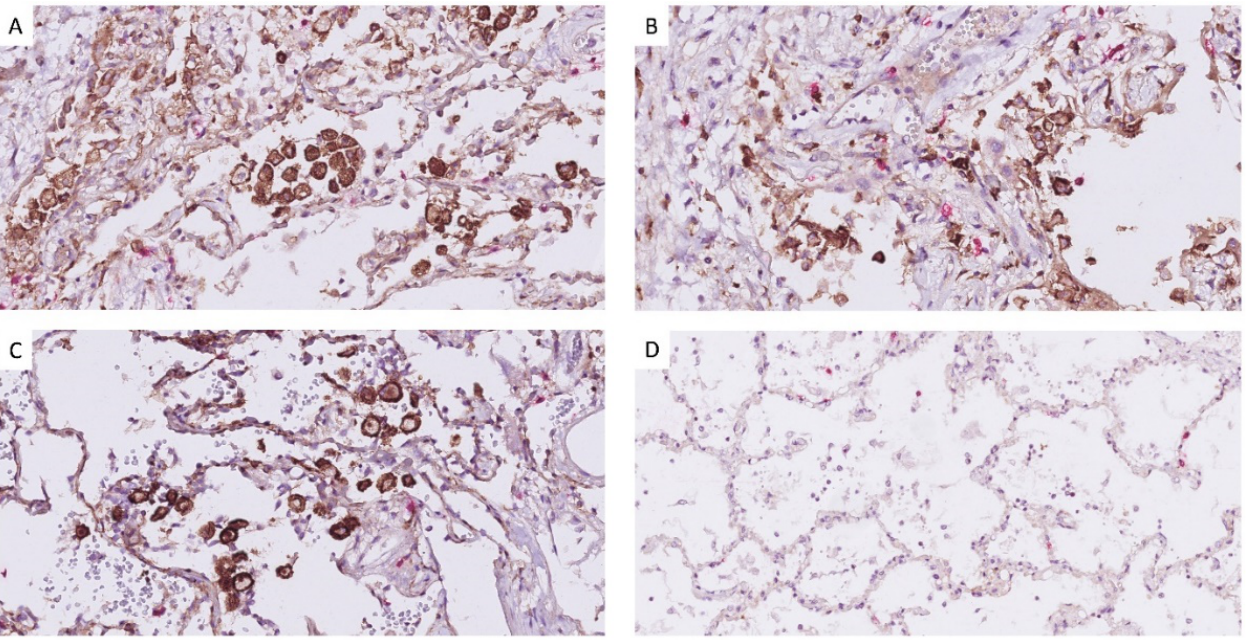
Figure 3. The increased expression of PD-L1 in lung tissue of deceased COVID-19 patients. PD-L1 is expressed on macrophages which are morphologically recognizable (stained in brown) and CD8 + T-cells (stained in red). ( A ) patient C10, ( B ) patient C11, ( C ) patient C7, and ( D ) PD-L1 expression is not detected in non-COVID-19 lung control. Note: slide was scanned at 40× resolution using NanoZoomer S360 digital slide-scanner (Hamamatsu, Japan) and visualized by NDP Viewer. The use of Pearson’s correlations coefficient shows a very strong correlation between sets of proteins, including (Flt3L/sCD40), (BTC/PTN), (IL-6/IL-8/VEGFA), (IL- 6/BTC/PTN), (CAPG/EDIL3), and (CXCL9/OSM/PD-L1) (Figure 4).